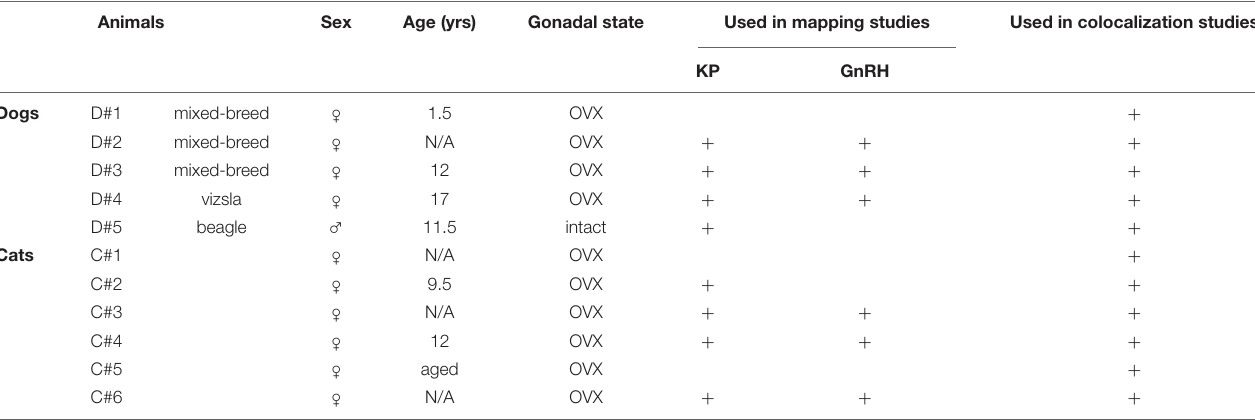
TABLE 1 | Basic data on canine and feline tissue samples and their use in different experiments. Animals